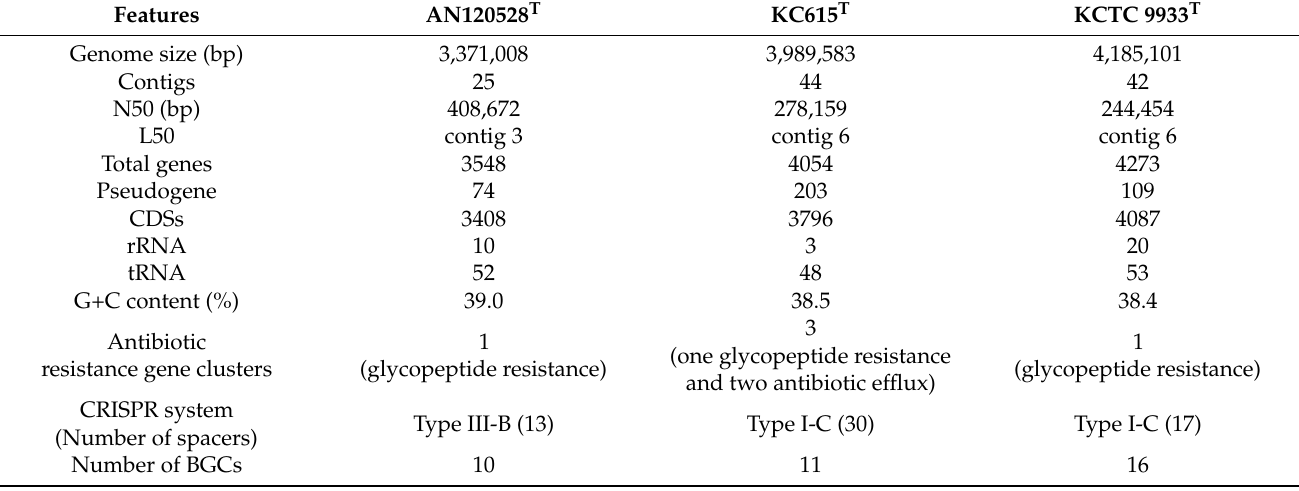
Table 3. General genomic and functional features of AN120528 T and related members of the genus Shimazuella